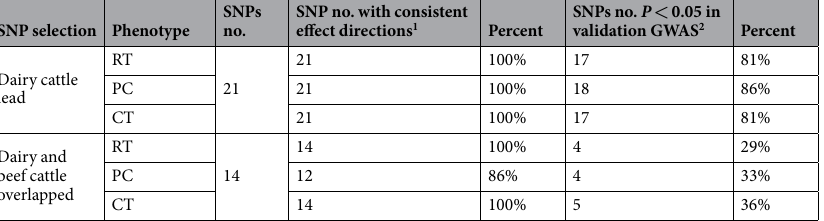
Genetic properties of raw traits (RT), principal components (PC) and Cholesky transformed traits (CT). Comparable with the previous results where daughter trait deviations of the dairy bulls were also analysed 9 , we identified the mid-to-high range of heritability estimates of bull’s RTs (Table 1). Using the trait